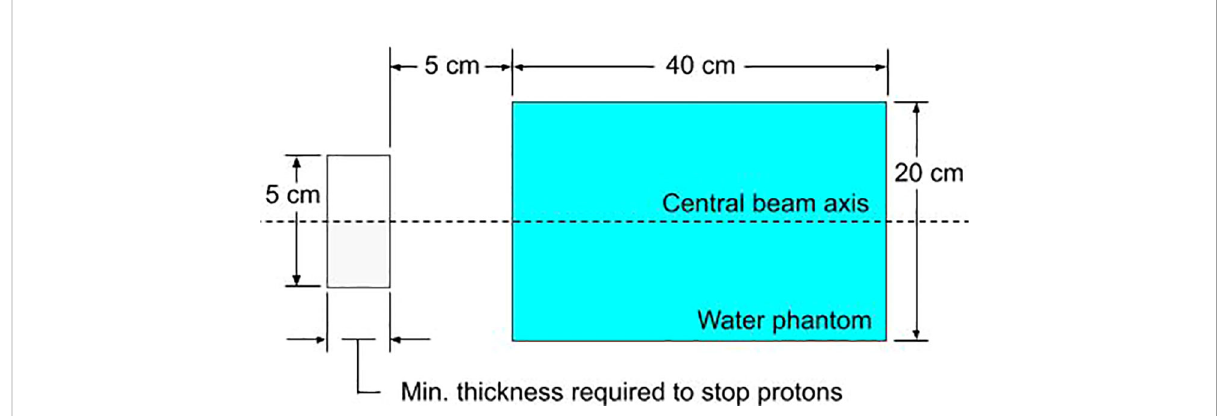
FIGURE 3 The simulated setup in TOPAS for evaluating the relative neutron dose for various block materials. The block aperture (gray) is cylindrical with a 5 cm diameter. The water phantom is cylindrical with a diameter of 20